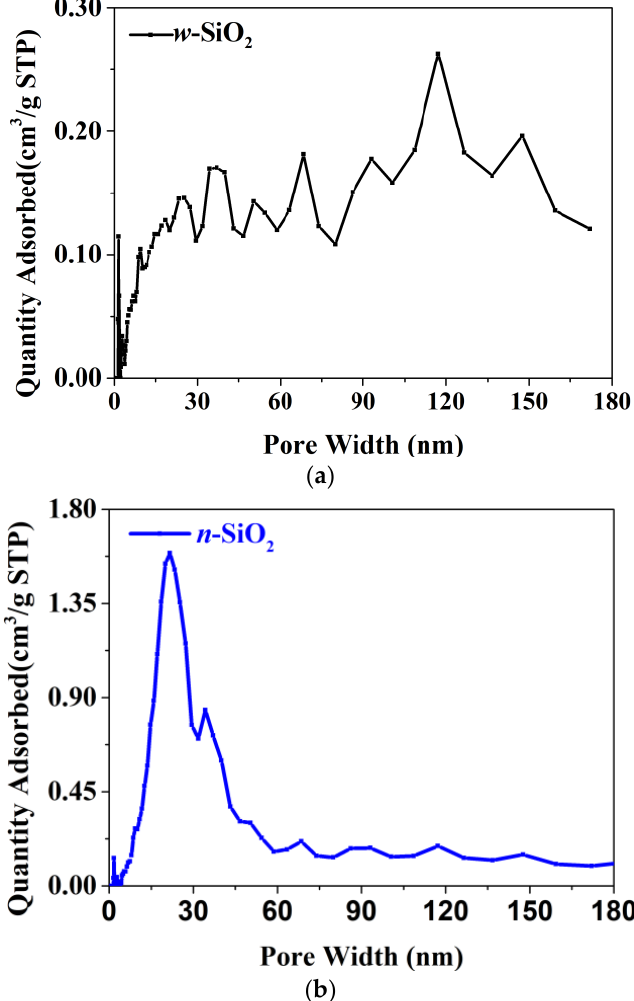
Figure 3. The pore size distribution of w -SiO 2 ( a ) and n -SiO 2 ( b )